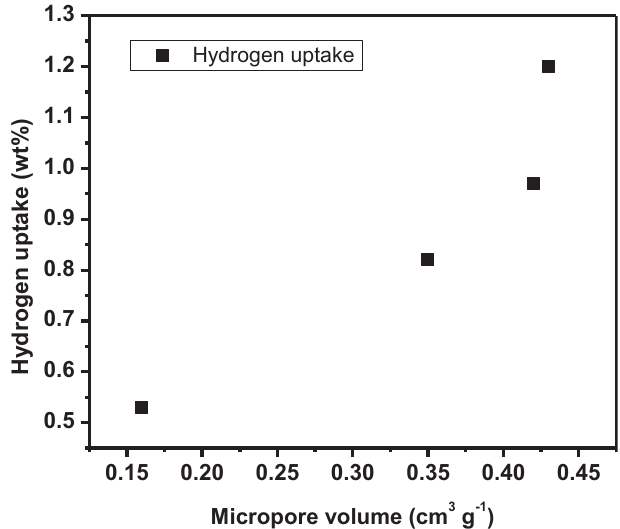
Fig. 9. Relation between stored maximum hydrogen content (wt.%) and total-pore volume (cm 3 /g) of activated carbon at 30 ° C and 40